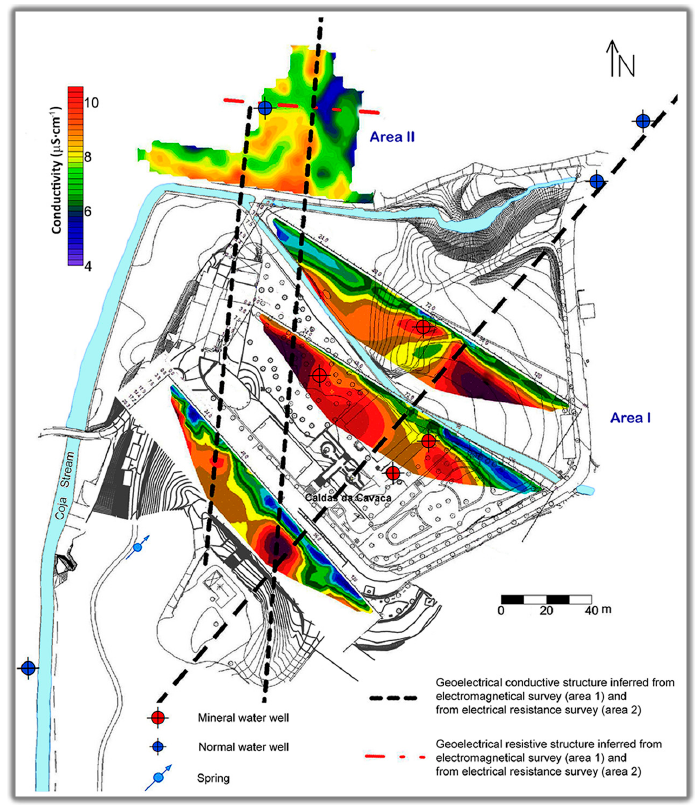
Figure 4. Synthetic interpretation of geophysical surveys for hydrogeological exploration (geoelectrical methods) in the area of Caldas da Cavaca, updated from [45,46,51,52].